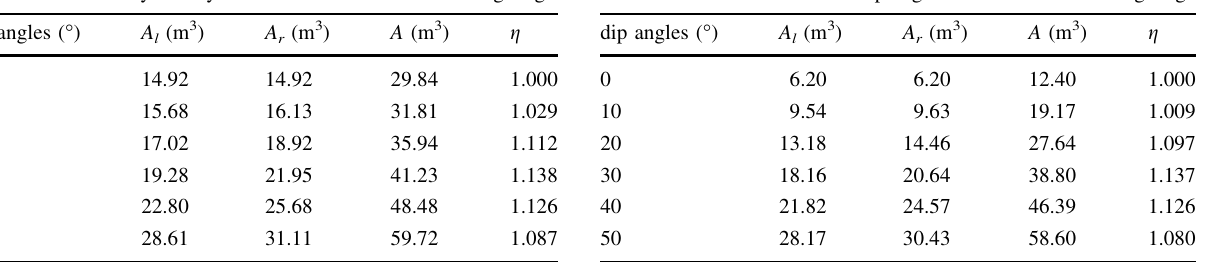
Table 4 Calculating drawing body volumes and volume